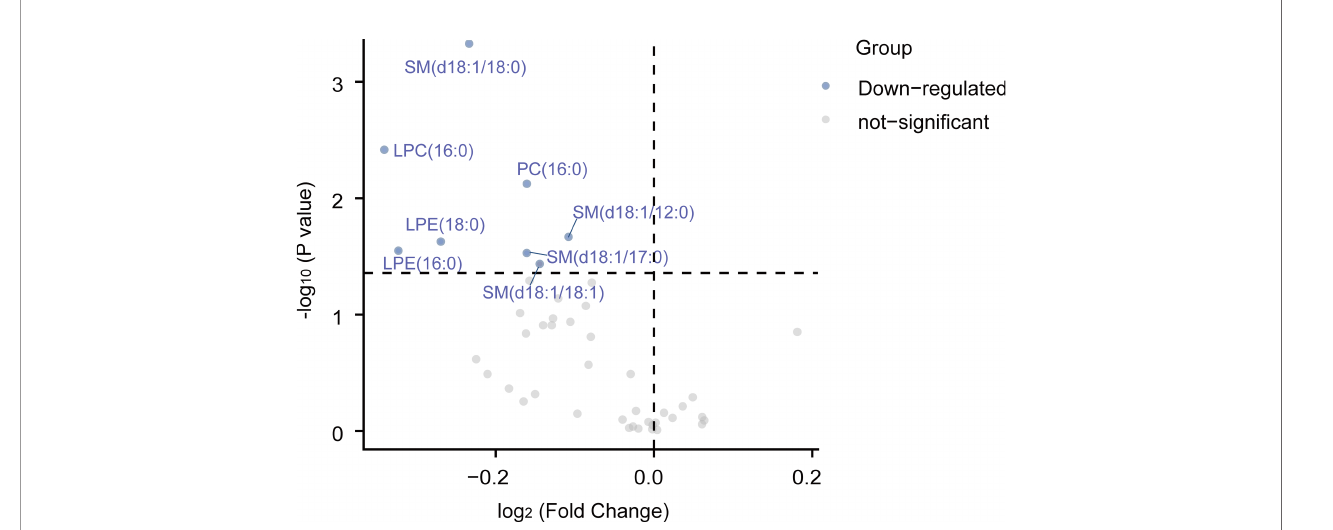
FIGURE 3 | The volcano plots of 45 serum lipid levels inT2DM groups before and after treatment. A total of 8 lipids are down-regulated when comparing levels of post-treatment levels to pre-treatment levels. Paired Wilcoxon tests were used to calculate statistical signi fi cance. Differentially abundant metabolites with different fold changes were individually color-coded with down-regulated lipids in blue and not-signi fi cant in grey. LPC, lysophosphatidylcholine; PE, phosphatidylethanolamine; LPE, lysophosphatidylethanolamine; PC, phosphatidylcholine; SM, sphingomyelin; Cer,